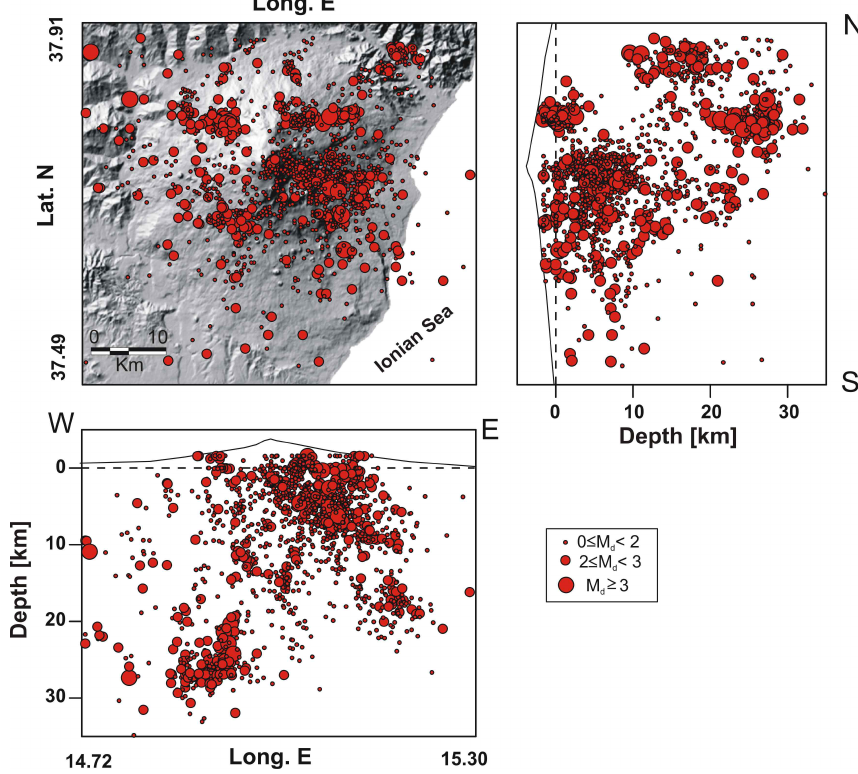
Fig. 2. Maps of the seismicity located by ESN for the period 2010–2012.